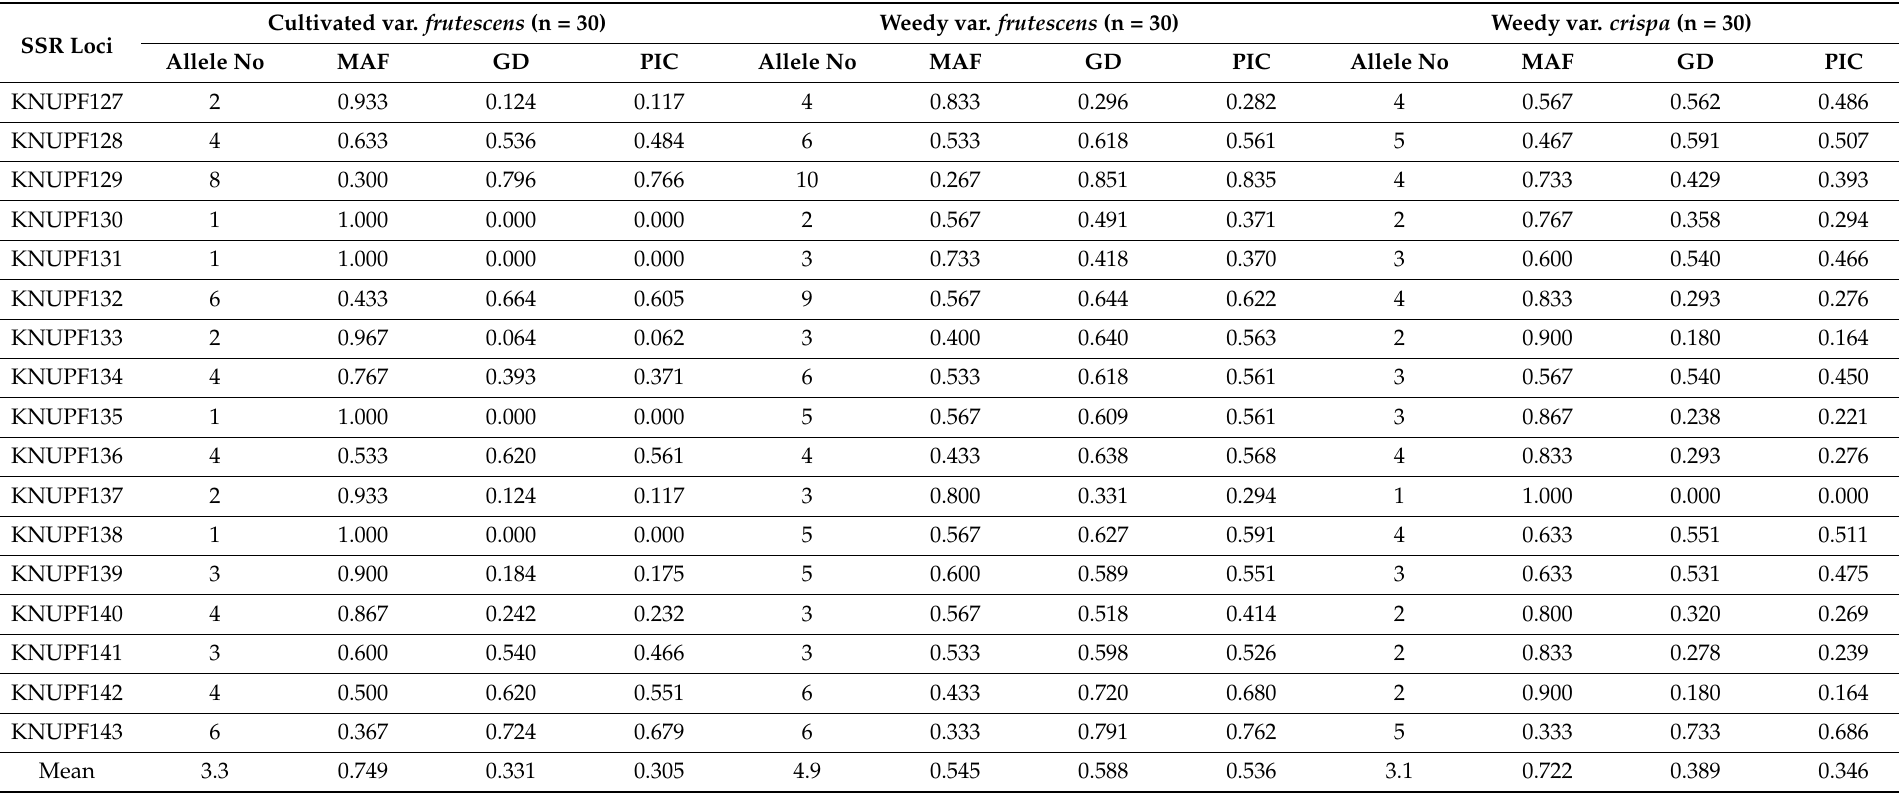
Table 2. Genetic variation obtained from each SSR locus among 90 accessions of Perilla crop and their weedy types collected from South Korea. Cultivated var. frutescens (n = 30) Weedy var. frutescens (n = SSR Loci